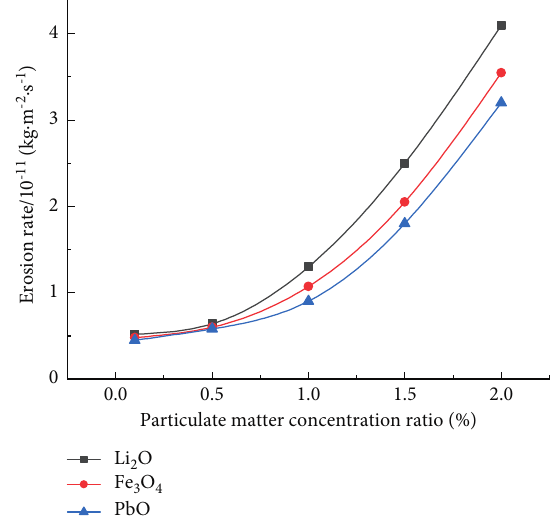
Figure 12: Effect of different concentrations and types on erosion rates.